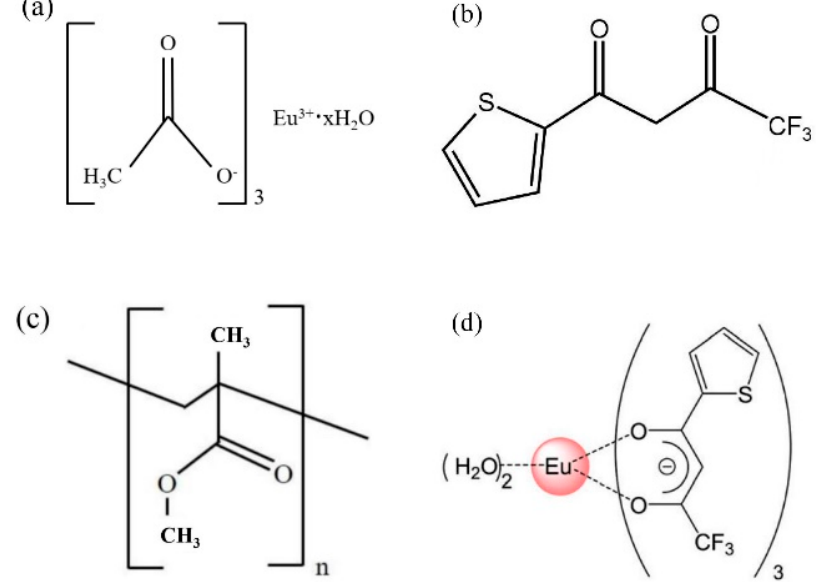
Figure 1. Schematic diagram of the structure of the experimental material: ( a ) europium acetate hydrate; ( b ) thiophenecarbonyl trifluoroacetone (TTA); ( c )polymethyl methacrylate (PMMA); ( d ) tris (2-thienyl trifluoroacetone) europium (III) [Eu (TTA) 3 (H 2 O) 2 ].